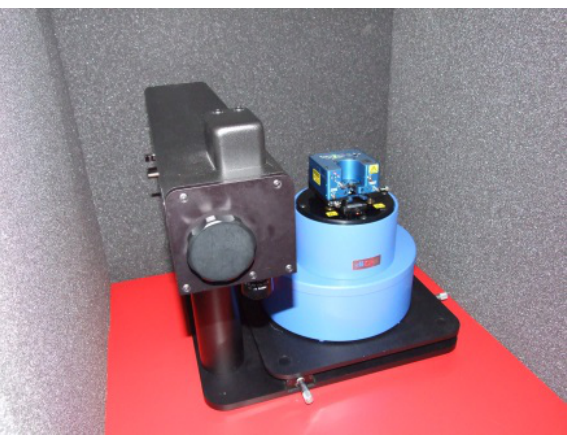
Figure 5: AFM instrument at DESY